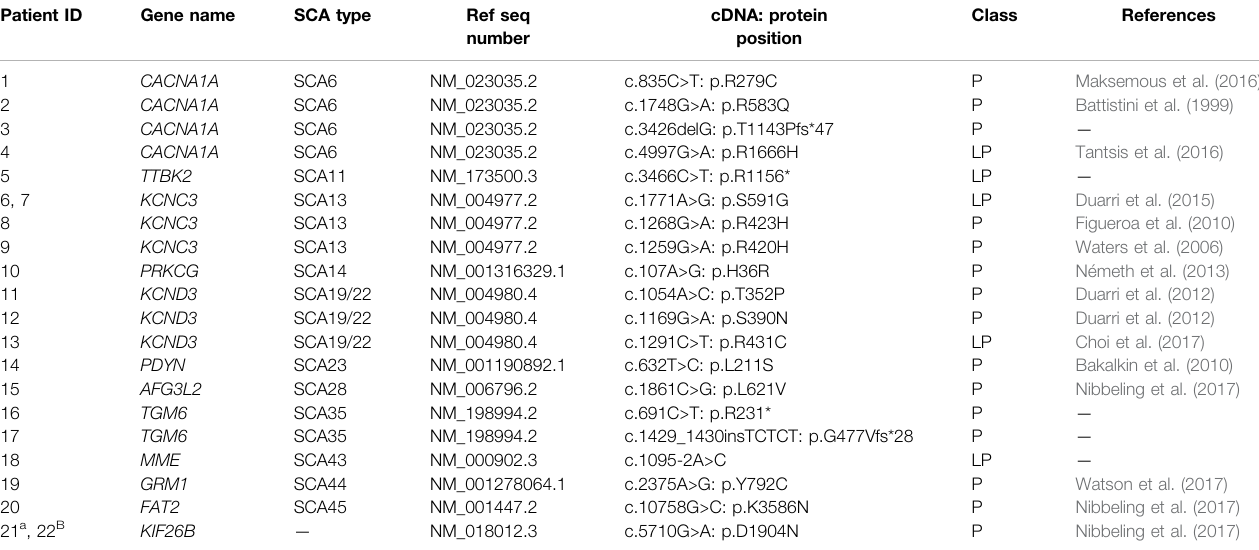
TABLE 2 | Pathogenic (P) and likely pathogenic (LP) variants identi fi ed in 22 patients. Patient